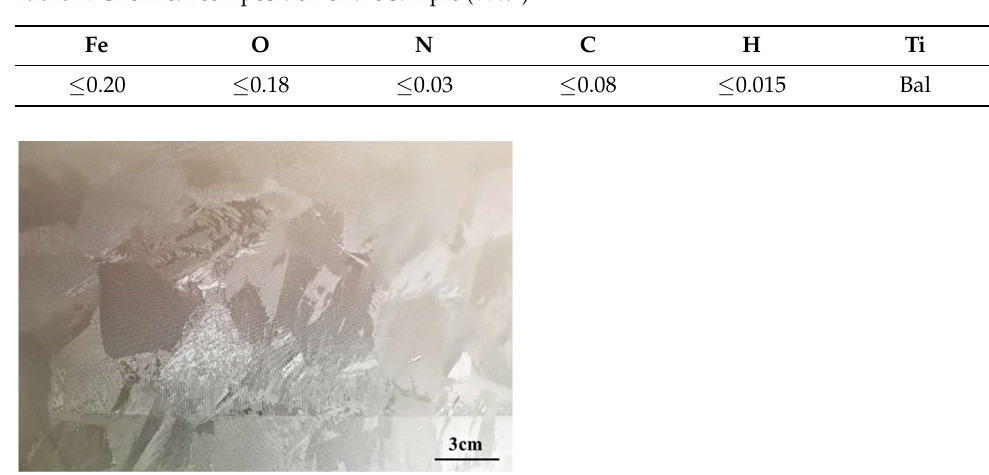
Table 1. Chemical composition of the sample (Wt%).